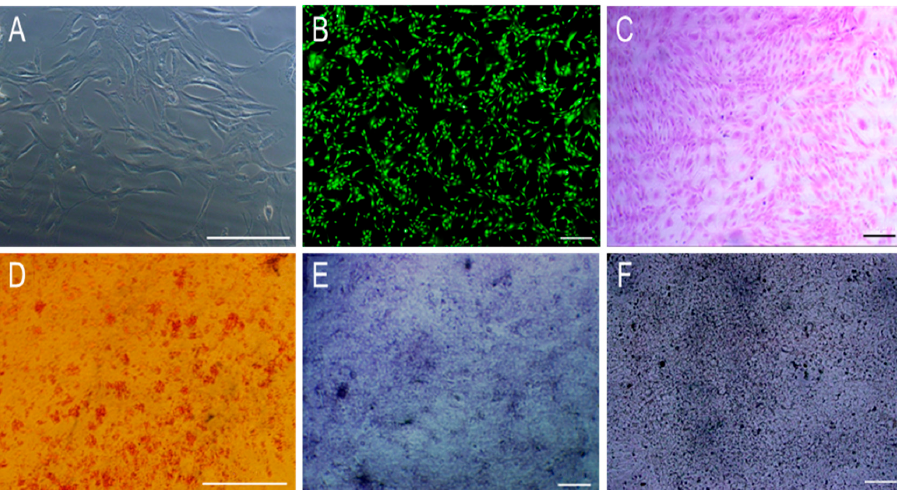
Figure 6. The morphology and differentiation of the 12th generation of MC3T3-E1 cells. ( A ): Cell morphology of the cells; ( B ): Calcein-AM staining of the cells; ( C ): Hematoxylin-eosin (HE) staining of the cells; ( D ): Alizarin red S staining after three weeks of osteogenic induction; ( E ): Alkaline phosphatase (ALP) staining after one week of osteogenic induction; ( F ): Von-Kossa staining after four weeks of osteogenic induction. Scale: A and D: 250 μ m. B,C,E and F: 500 μ m.